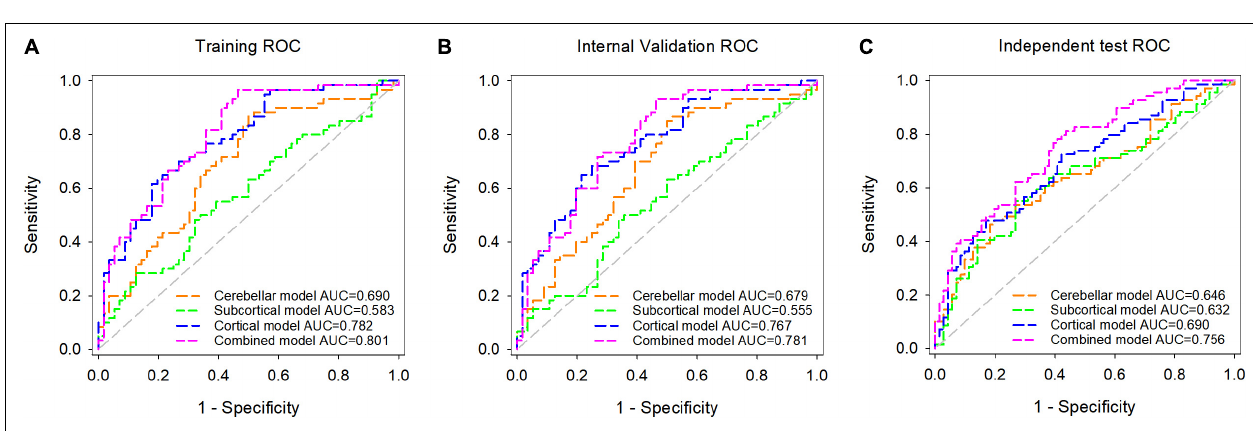
FIGURE 4 | Receiver operating characteristic (ROC) analysis of the cerebellar model, subcortical model, cortical model, and combined model in the training dataset (A) , internal validation dataset (B) , and independent test dataset (C) .